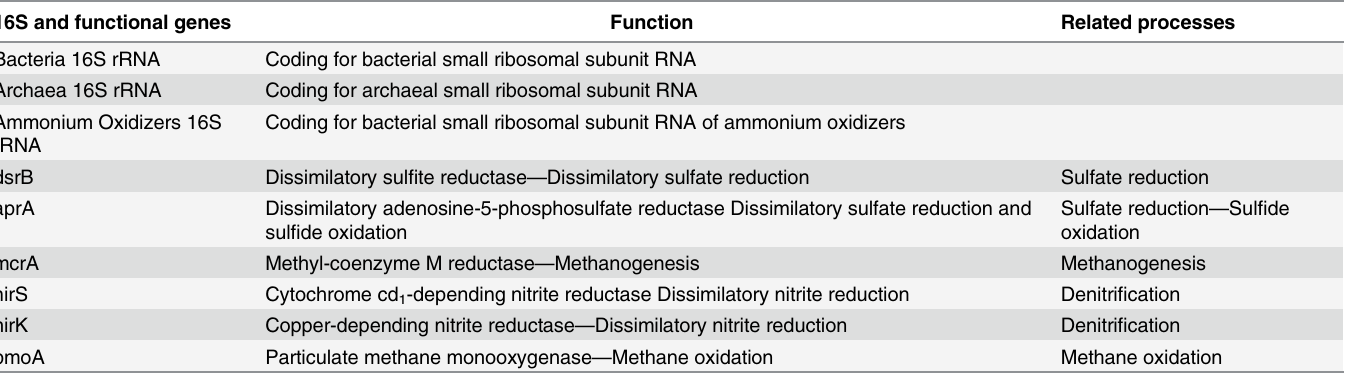
Table 1. Applied PCR approaches and the function of their target